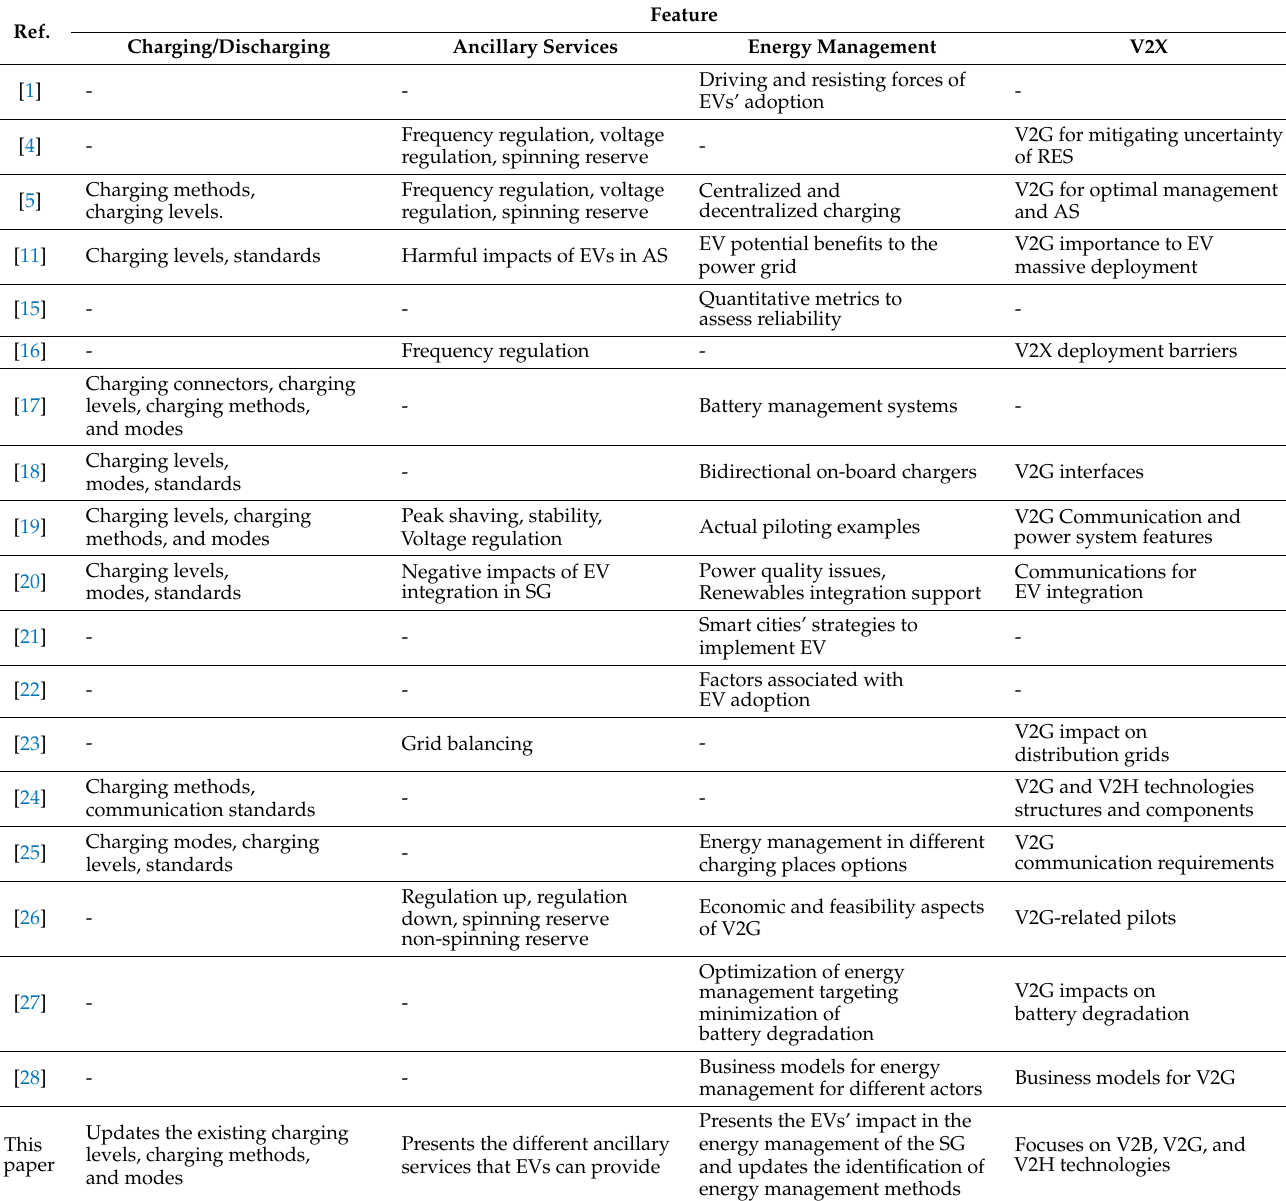
Table 1. Contributions of related review papers and comparison with present